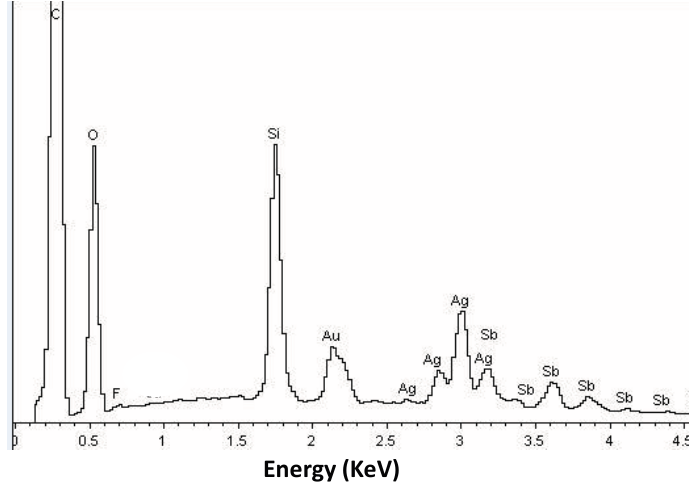
Figure 8. Energy-Dispersive X-ray Spectrometry (EDS) analysis recorded from Ag(0) nanoparticles in EPOX.